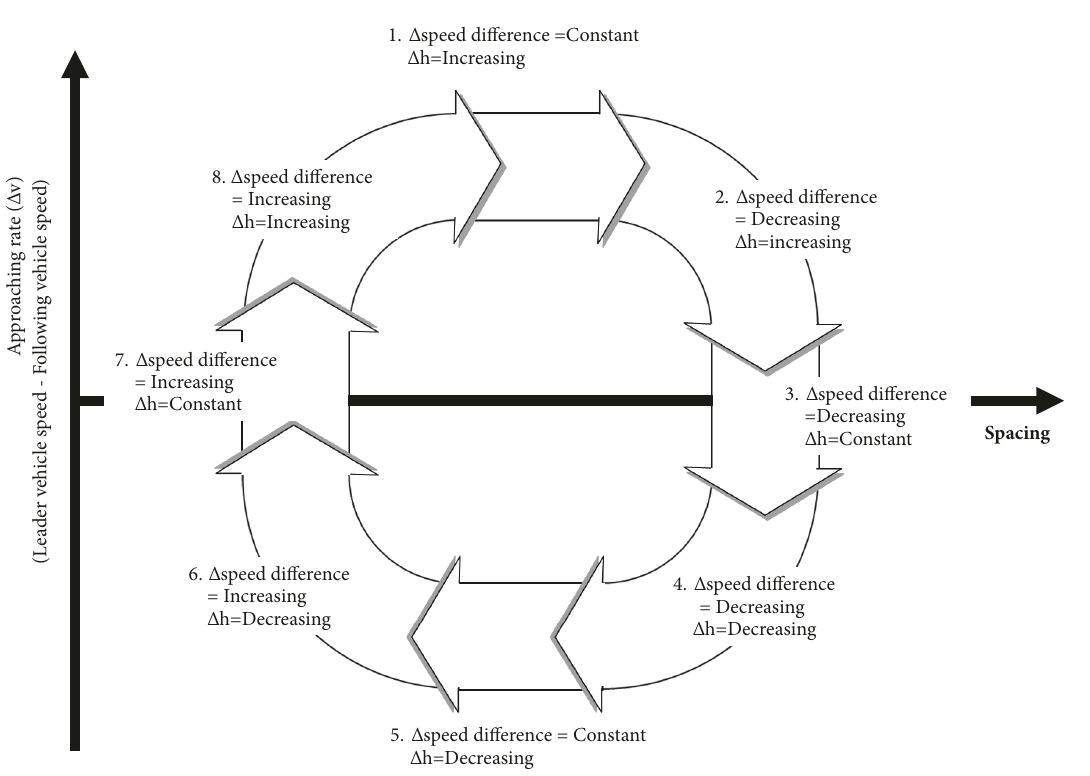
Figure 1: The Classification of driving state of subject